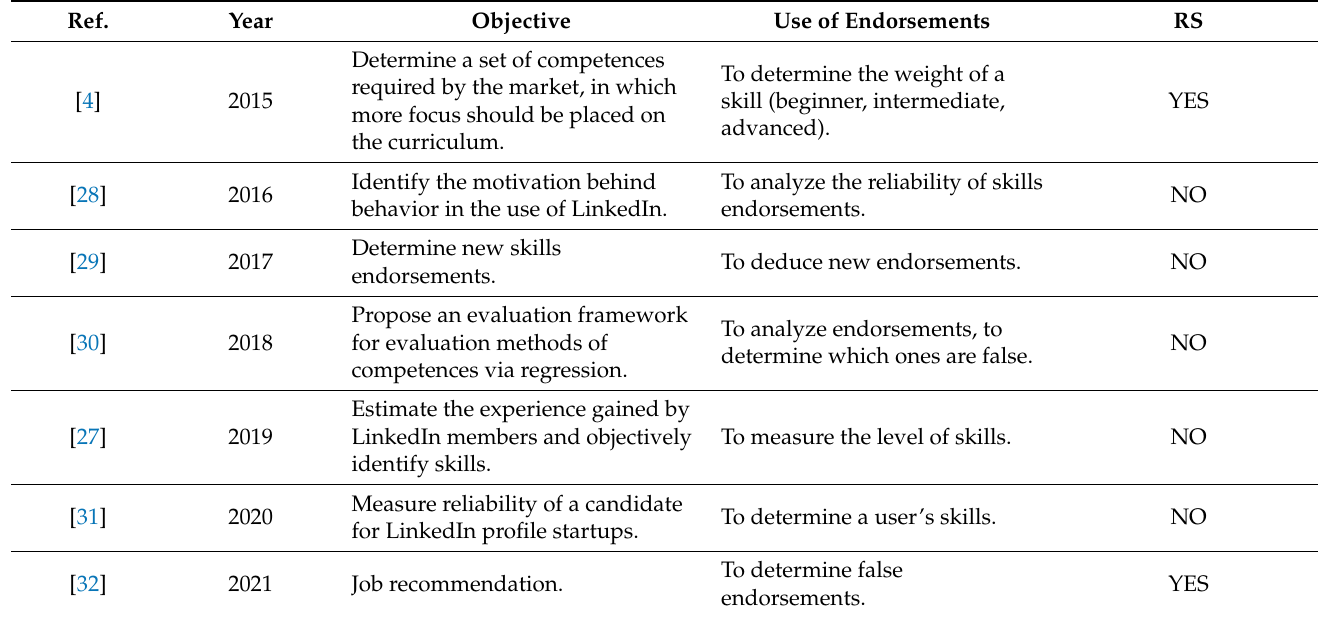
Table 2. Research related to the use of LinkedIn